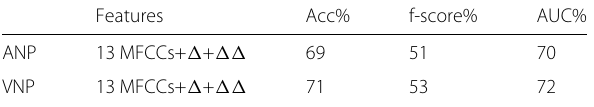
Table 4 Overall binary classification performance